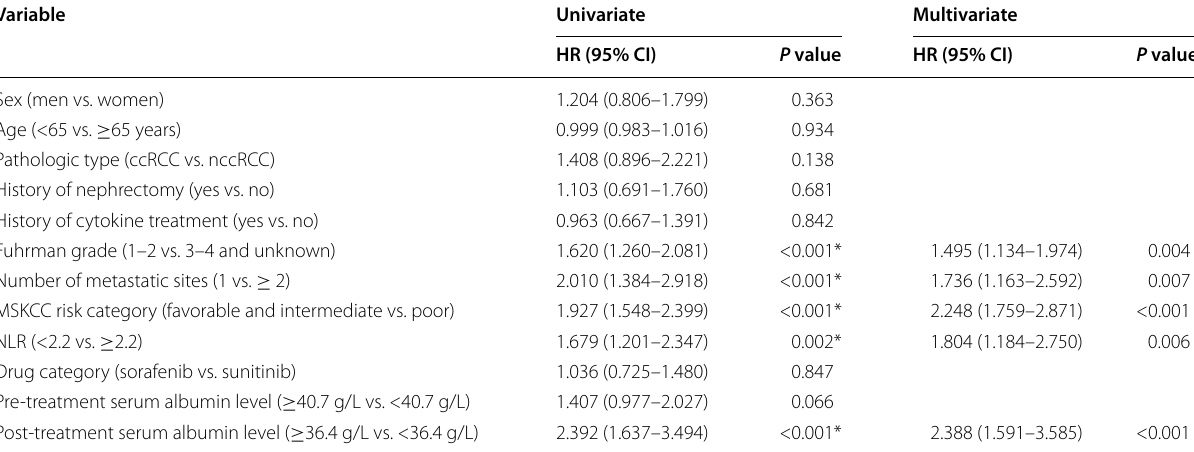
ccRCC, clear cell renal cell carcinoma; nccRCC, non-clear cell renal cell carcinoma; NLR, neutrophil-to-lymphocyte ratio; MSKCC, Memorial Sloan Kettering Cancer Center; HR, hazard ratio; CI, confidence interval * Variables with P values <0.05 in univariate analysis were considered for multivariate